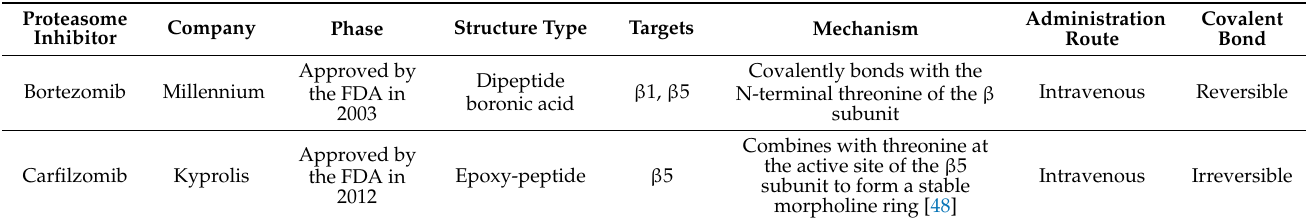
Table 1. Proteasome inhibitors that are approved or currently investigated in clinical